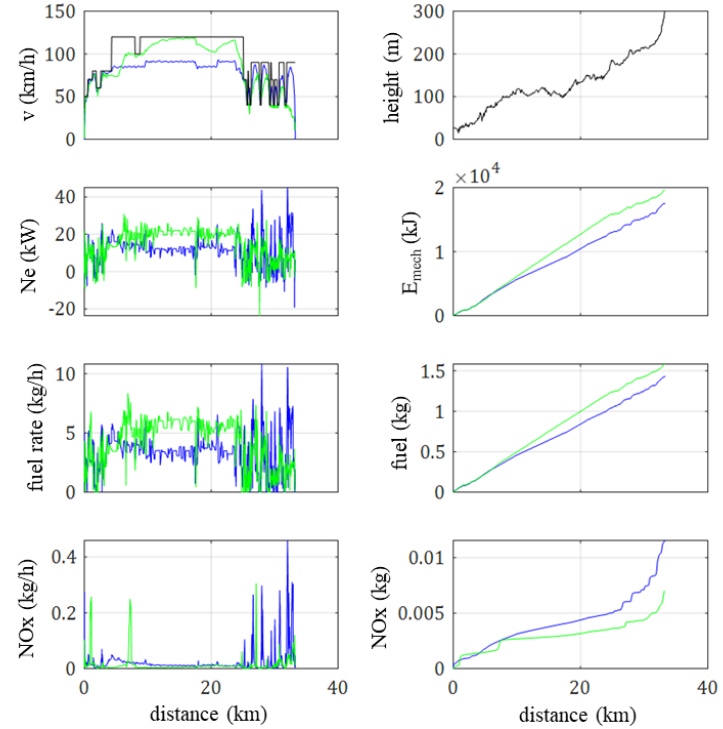
Figure 7. Engine parameters for minimum fuel consumption (blue) and for minimum NOx (green) production driving